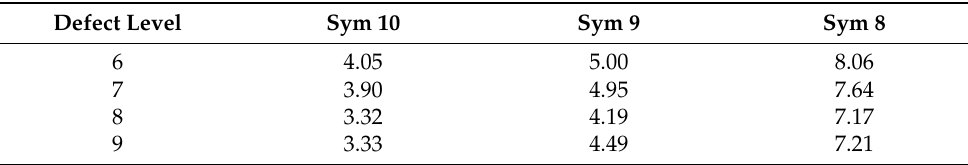
Table 2. Variation in the DEV for Symlets family.